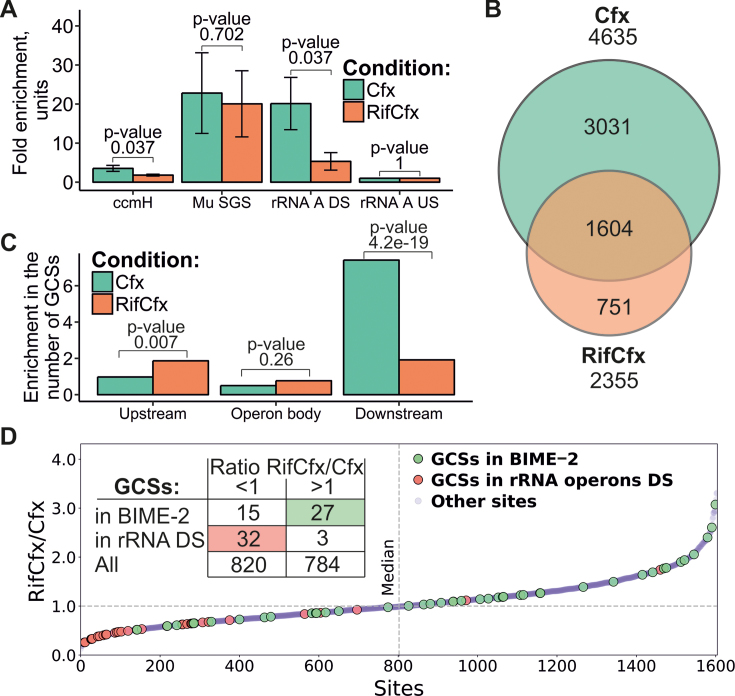
Transcription facilitates gyrase activity. (A) Enrichment observed at several genomic sites by Topo-qPCR for Cfx and RifCfx (data for three replicas). Error bars constructed as ±2 standard errors, P-values for t-test for means are indicated above the bar pairs. (B) Venn diagram showing overlap of Cfx and RifCfx GCSs sets. (C) GCSs relocation from downstream regions of rRNA operons when transcription is inhibited with rifampicin. Enrichment in the number of GCSs, which is a ratio of the number of observed GCSs to the number of expected GCSs (statistic—Fisher exact test), is plotted. (D) GCSs shared between Cfx and RifCfx sorted by ratio of their N3E values. GCSs that fall in 5 kb downstream regions of rRNA operons (red dots) have a significant tendency to have lower N3E values when cells are treated with Rif (binomial test, P-value = 0.015). On the other hand, GCSs that fall into REPs (green dots) reveal tendency to increase N3E under the same conditions (binomial test, P-value = 4e–7).